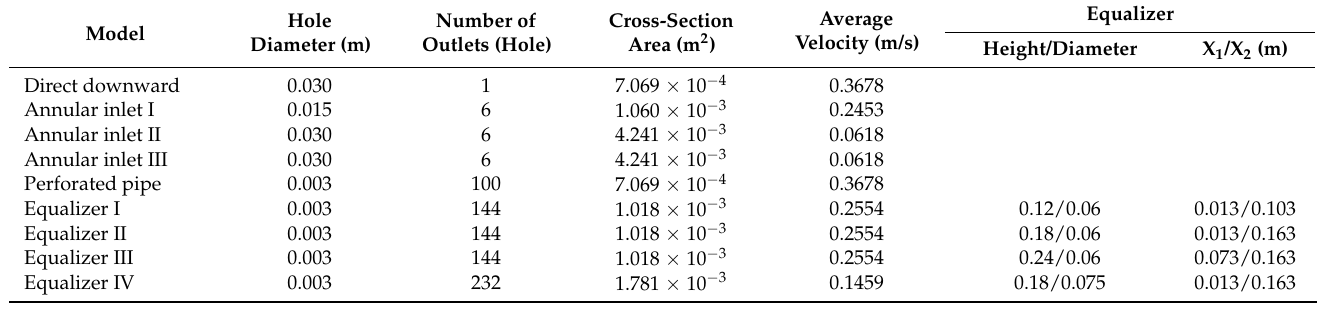
Table 1. The specifications of the modified inlet pipes.